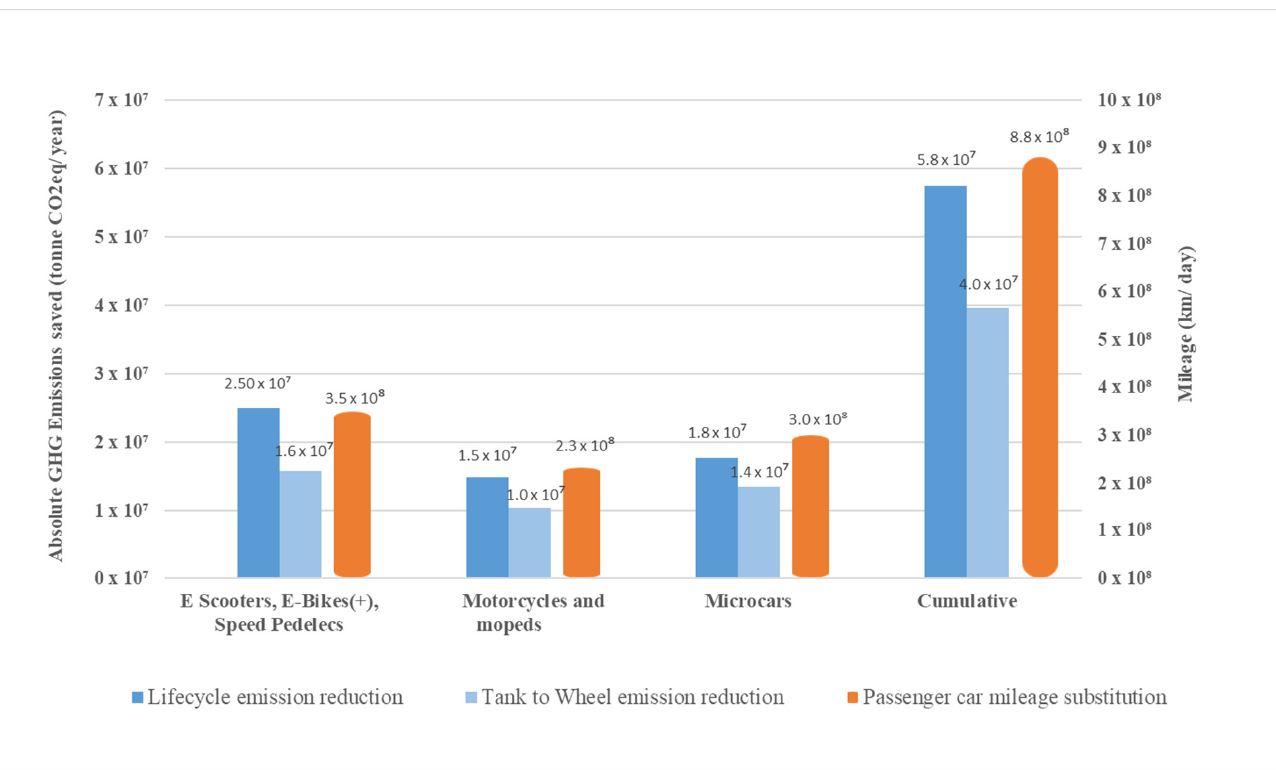
Figure 5. Emission reduction potential by LEV categories (“Lifecycle emissions” include vehicle production, fuel/electricity production, and vehicle use).